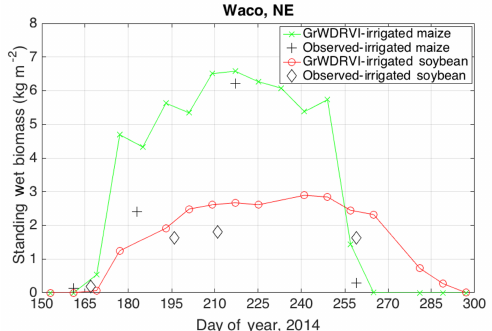
Figure 5. Time series of standing wet biomass for two study sites (irrigated maize and irrigated soybean) near Waco, NE, over the 2014 growing season. The graph contains the observed in situ sam- pling in addition to the GrWDRVI estimates using the equations summarized in Table S3. See Table 3 for GrWDRVI values and Ta- ble 4 for in situ